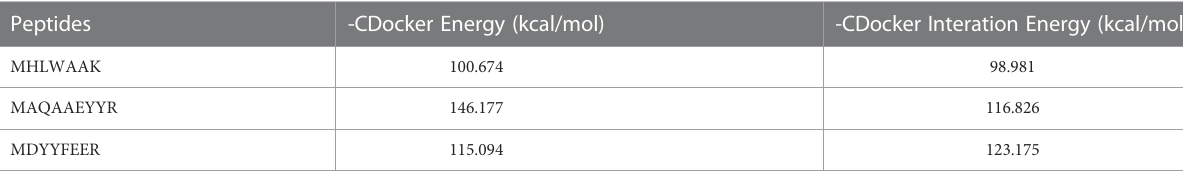
TABLE 3 Docking energies for optimal conformation of three active peptides and Keap1.